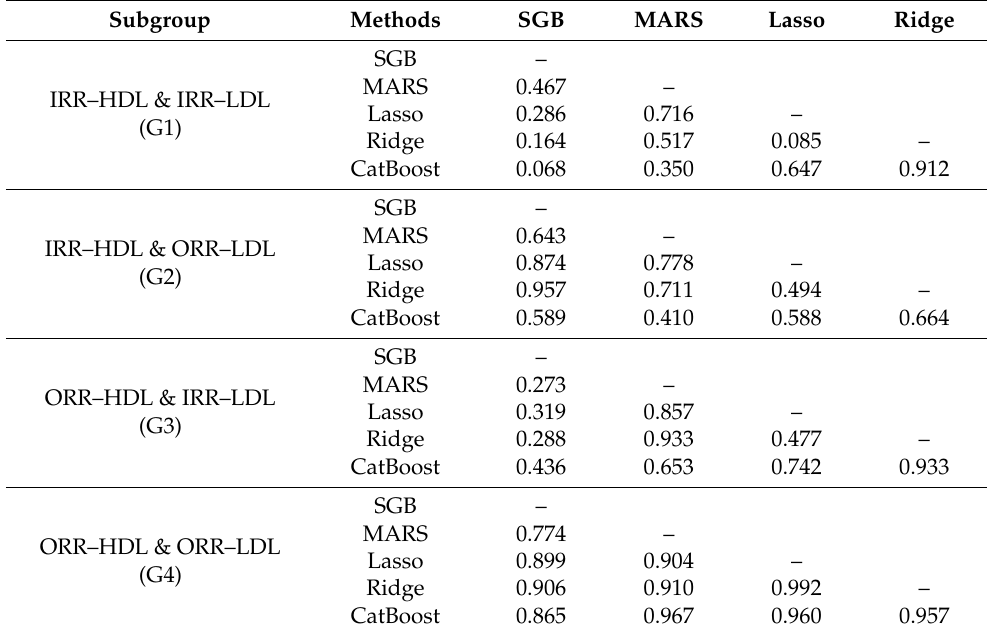
Table 4. Pairwise comparisons of AUC values of the five used ML methods in all subgroup using DeLong’s